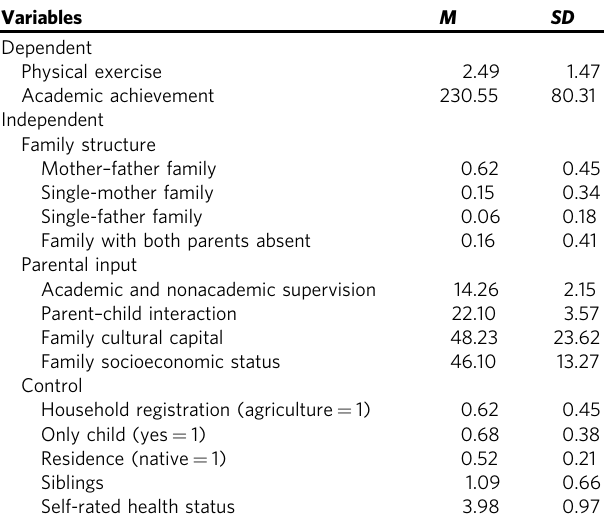
Table 1 Statistical results for all variables ( N =